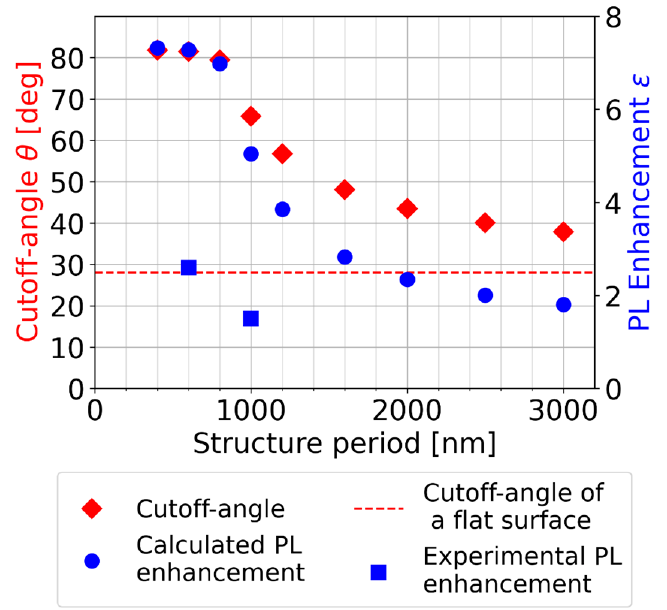
Figure 8. Comparison of calculated cutoff angles and PL enhancement for varying structure period at fixed sinusoidal amplitude of 100 nm for a wavelength of 950 nm. The cutoff angle (red data, left axis) is defined as the emission angle at which less than 1% of PL light can exit the SiO x layer. The dashed line shows the cutoff angle for a flat sample (28 deg). The blue data shows the calculated and measured PL enhancement (right axis) due to the periodic surface grating compared to a flat surface.